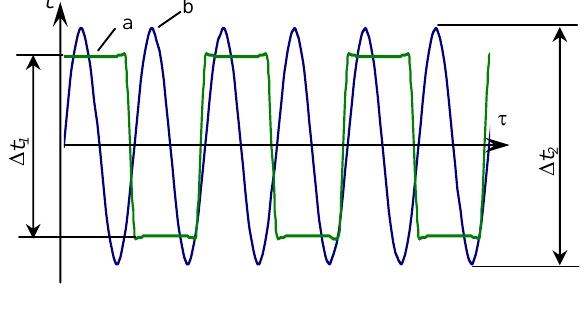
Fig. 3. Case examples of plant leaf position angle β change with respect to the Sun’s radiation. Explanations are given in the text